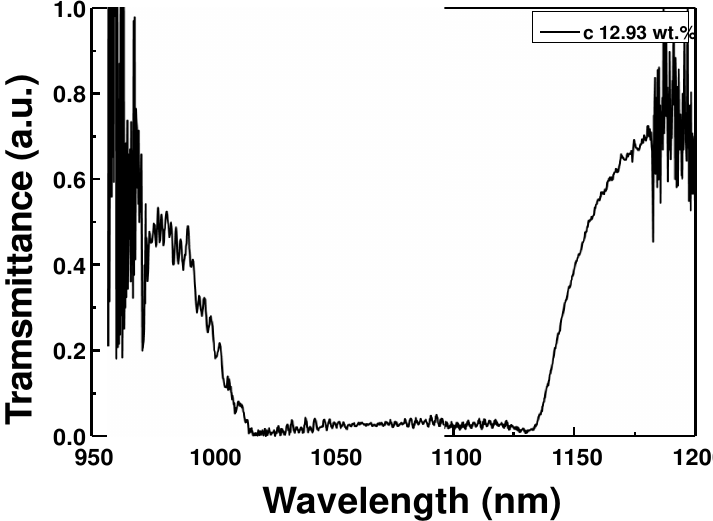
Figure 1. Transmission optical spectrum of CLC with a chiral dopant concentration of 12.93 wt.%. The fabrication process of the CLC cell based on the fiber ferrule is portrayed in Figure 2. The fiber optic connector with ferrule used in this experiment is an FC